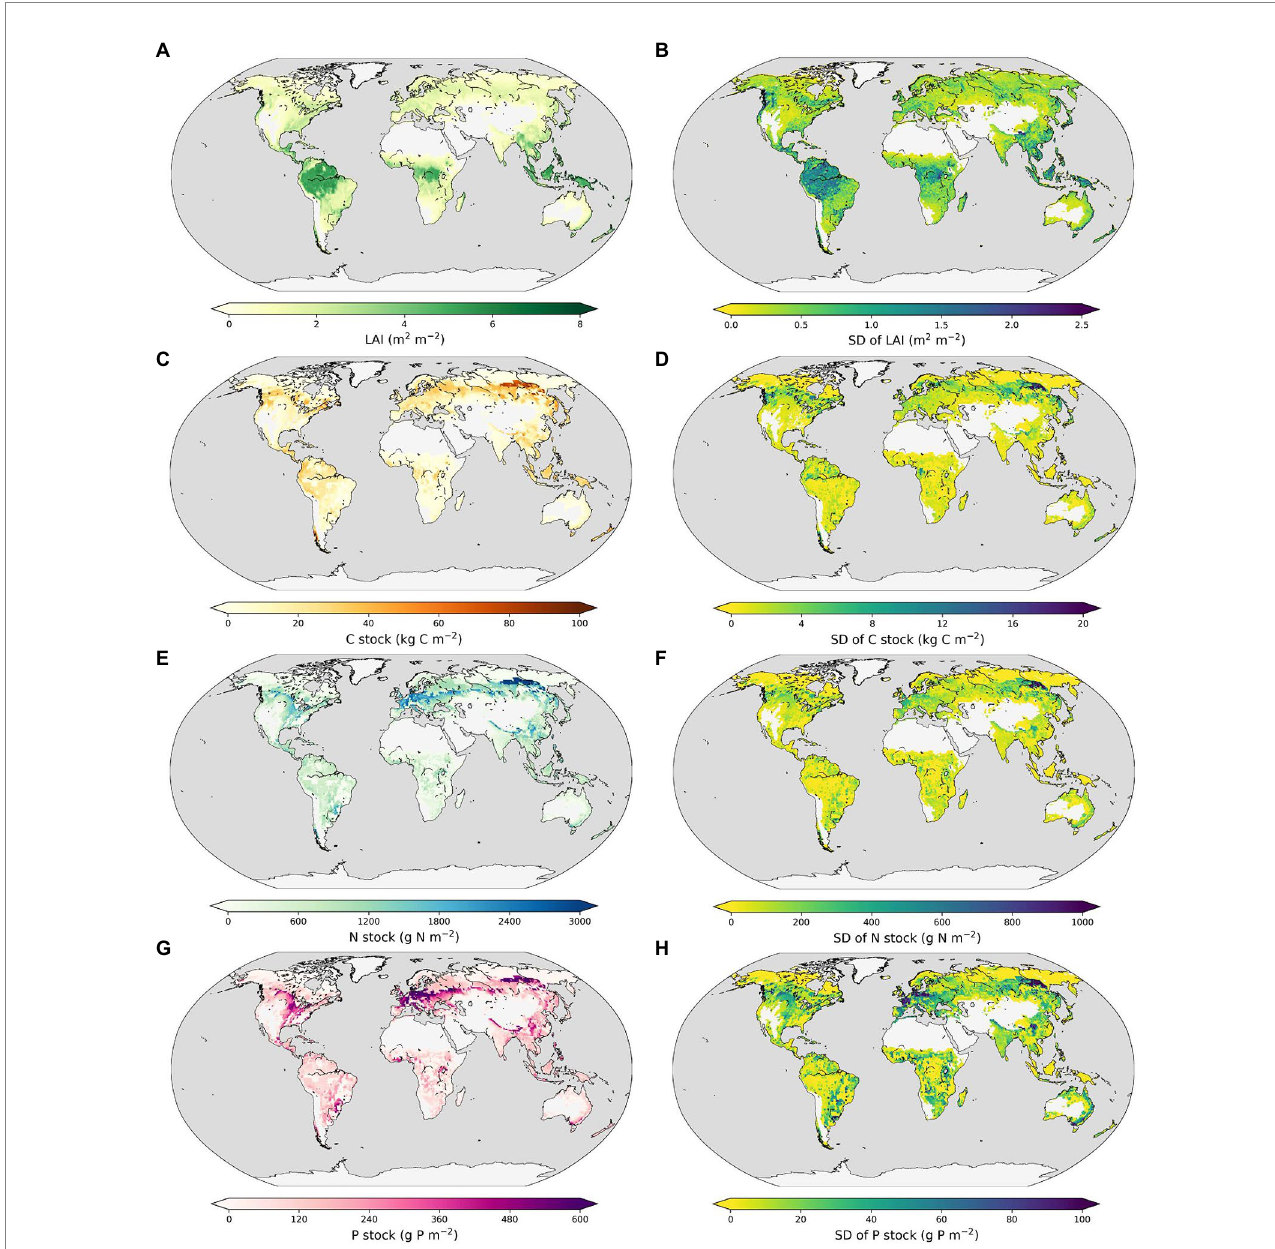
FIGURE 2 Spatial distributions of annual leaf area index (LAI, A ), carbon (C) , nitrogen (E) and phosphorus (G) storage and the corresponding standard deviation of LAI (B) , C (D) , N (F) , and P (H) storage among three satellite-derived simulations. Note that we only consider the organic pools for nitrogen and phosphorus in this